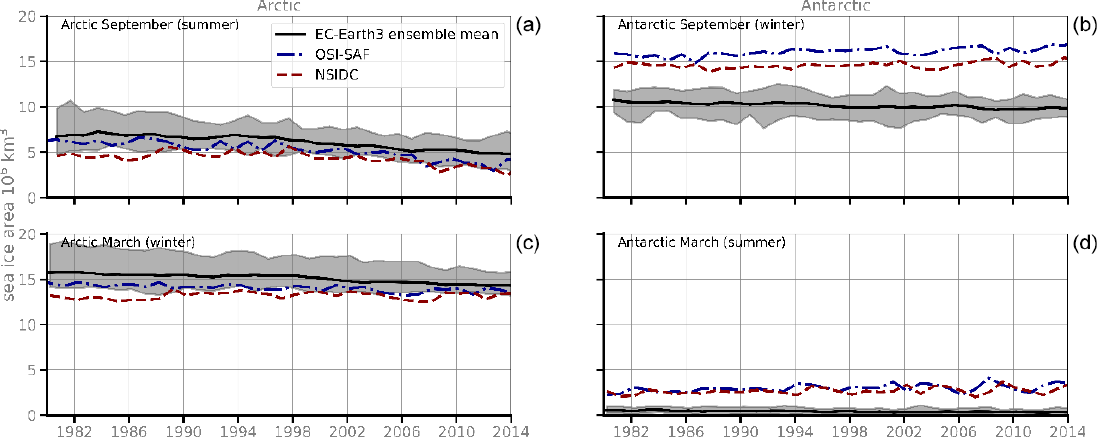
Figure 10. Time series of Arctic (a, c) and Antarctic (b, d) sea ice area for both EC-Earth3 (ensemble mean as thick solid lines) and satellite observations (OSI SAF as blue dash-dotted lines and NSIDC as dashed lines). The EC-Earth3 ensemble minimum up to maximum value is represented by the shading around the ensemble